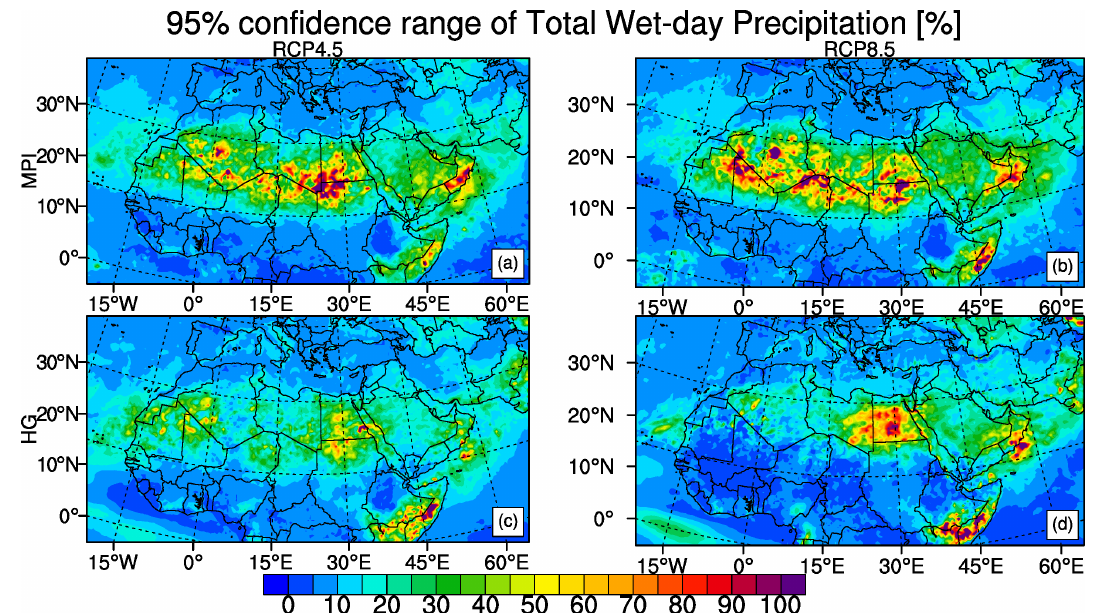
Figure 10. The 95 percentile of temporally averaged changes in the total wet-day precipitation (PRCPTOT) for the period of 2071–2100 displayed as differences (in %) with respect to the reference period 1971–2000 for the model MPI-ESM-MR with RCP4.5 ( a ) and RCP8.5 ( b ) and for the model HadGEM2-ES with RCP4.5 ( c ) and RCP8.5 ( d